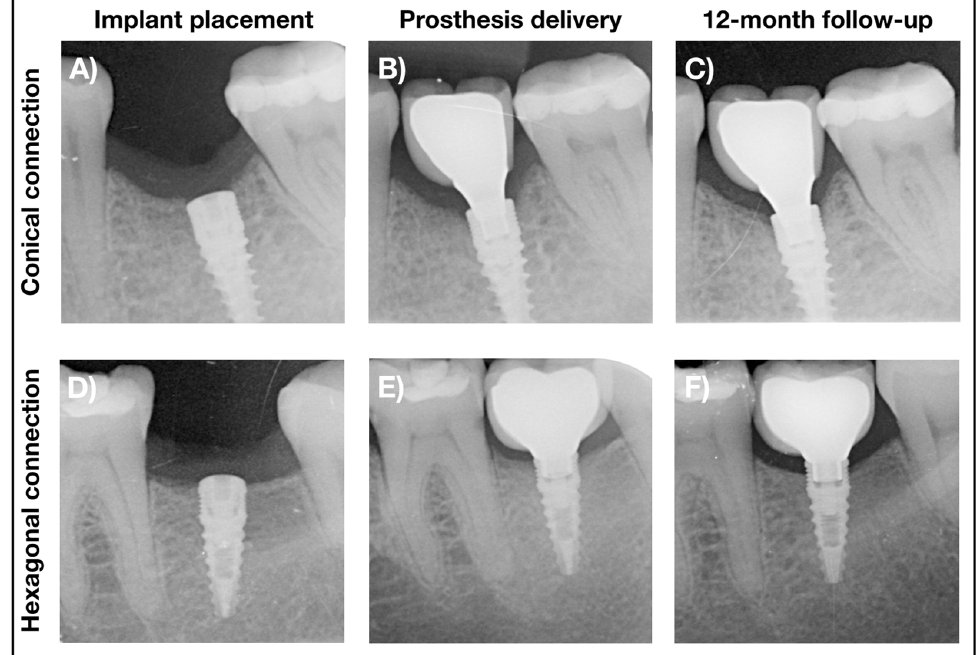
Figure 2. Representative radiographs of the implants at implant placement ( A , D ), prosthesis delivery ( B , E ) and 12 ‐ month follow ‐ up ( C , F ) for the conical ( A – C ) and hexagonal ( D – F ) connection groups. Several clinical measurements were also recorded at the time of implant